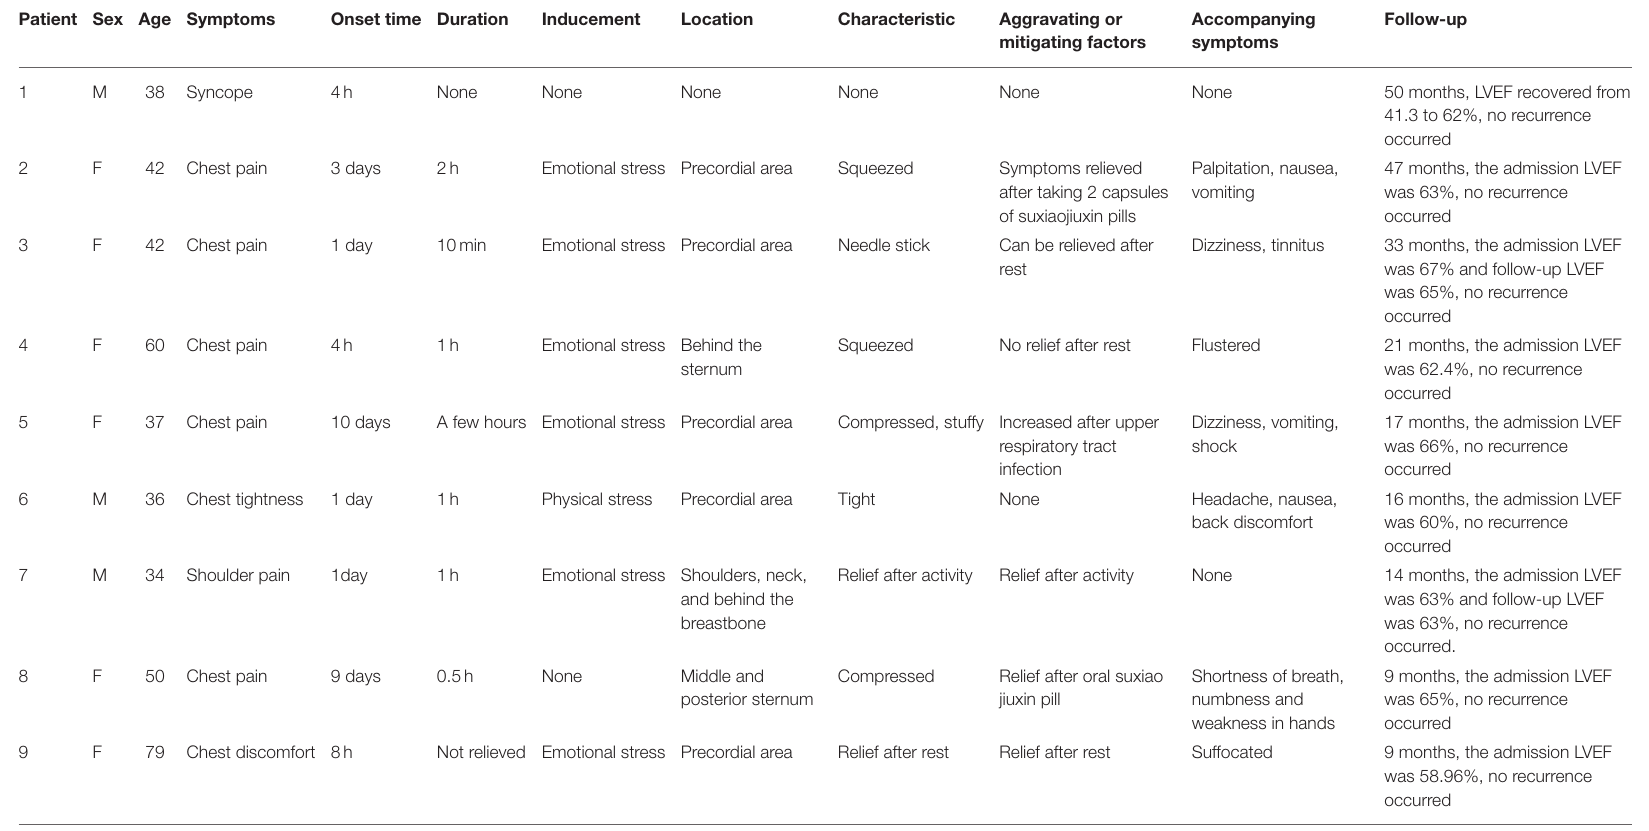
TABLE 2 | Comparative analysis of clinical characteristics of 9